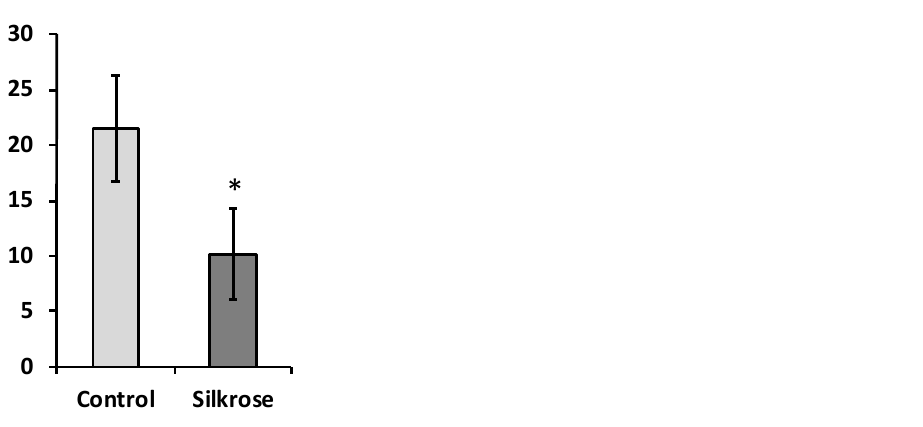
Figure 4. Effect of silkrose treatment on the number of Benedenia seriolae parasites per individual yellowtail at aquaculture field site. Results are presented as mean ± standard error. Asterisk indicates statistically significant differences compared with control group (* p < 0.05).